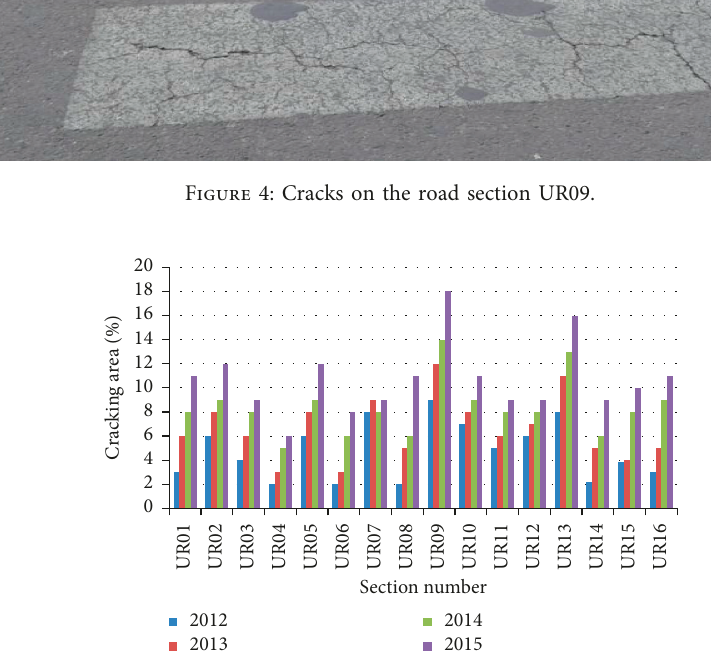
Figure 5: Progressive variation of the cracking area for the road sections UR01 to UR16.